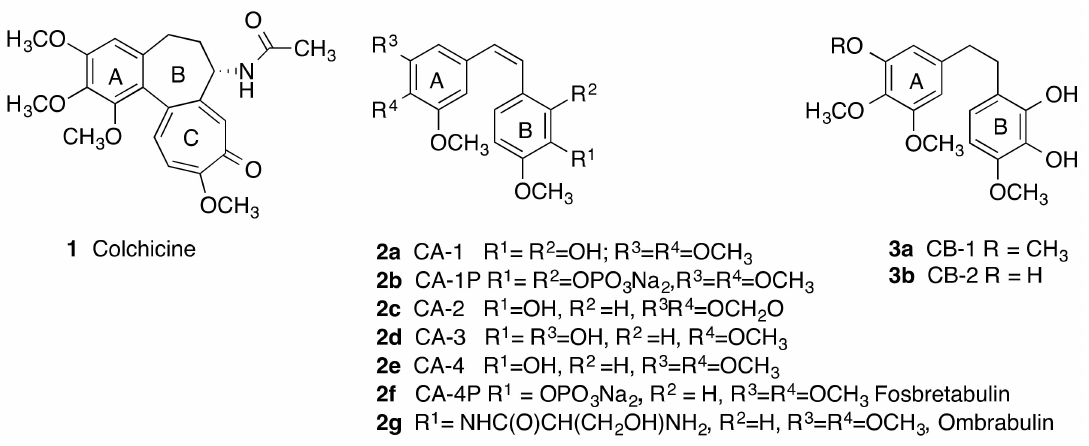
Figure 1. Colchicine ( 1 ), combretastatins CA-1 ( 2a ), CA-1P ( 2b ), CA-2 ( 2c ), CA-3 ( 2d ), CA-4 ( 2e ), CA-4P (fosbretabulin) ( 2f ), ombrabulin ( 2g ), CB-1 ( 3a ) and CB-2 ( 3b ).